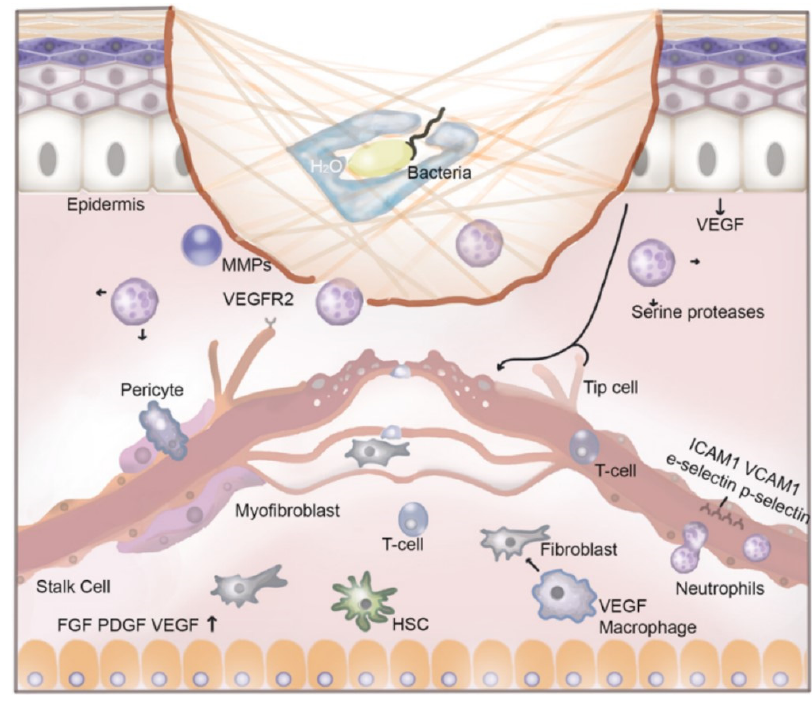
Figure 2. The process of wound